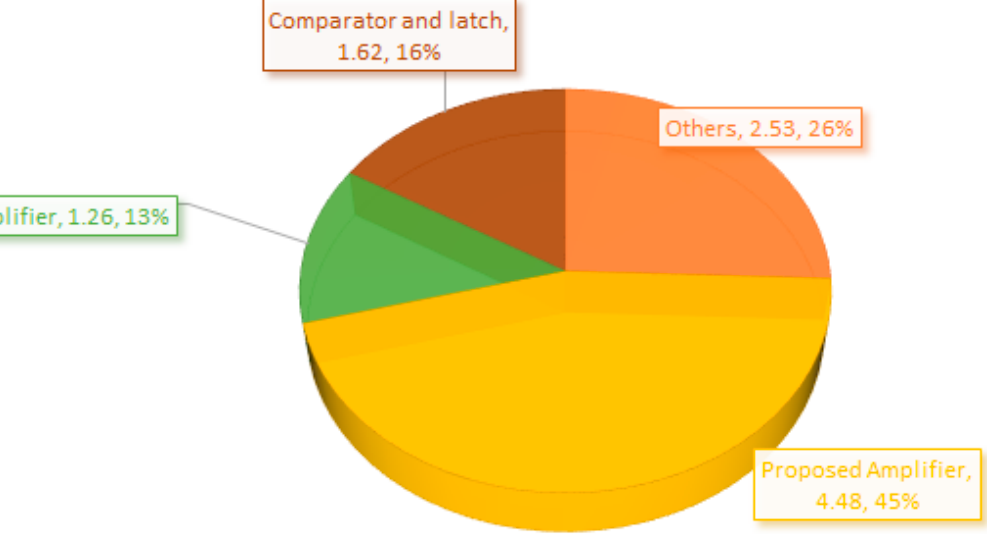
Figure 21. The measured power breakdown (in μW and percent ).